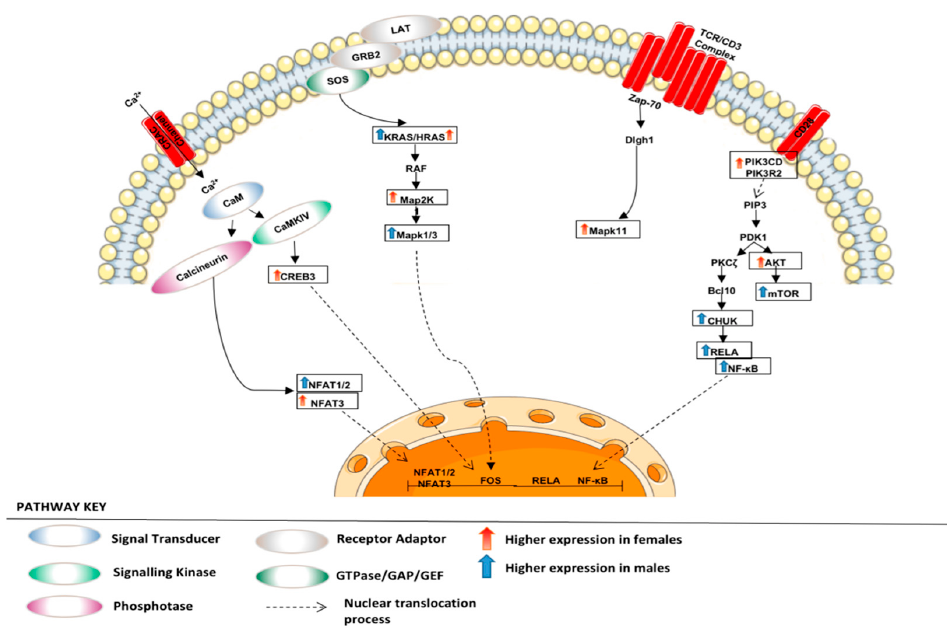
Figure 9. Regulation of T cell receptor signalling. The figure depicts various adaptors and enzymes involved in regulating TCR signalling in our LUAD cohort.